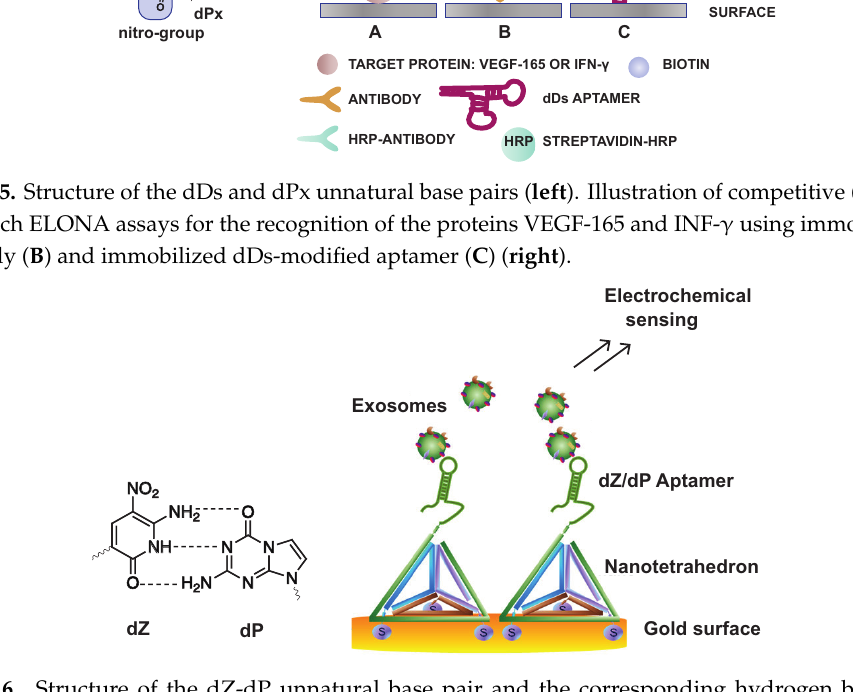
Figure 6. Structure of the dZ-dP unnatural base pair and the corresponding hydrogen bonding interactions